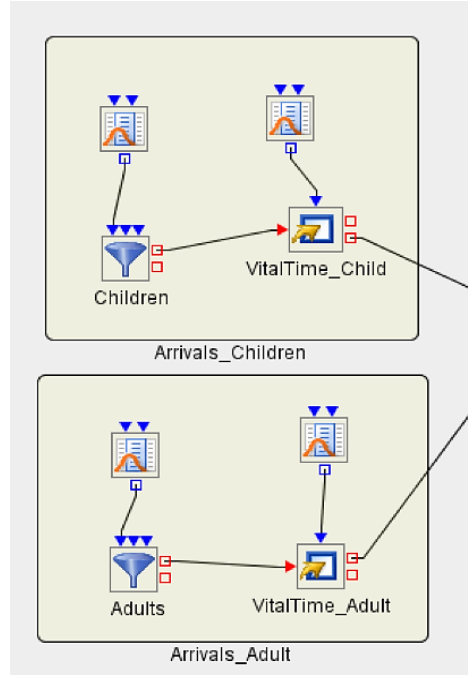
Figure 2. Simulation for an urgent care clinic (first component).